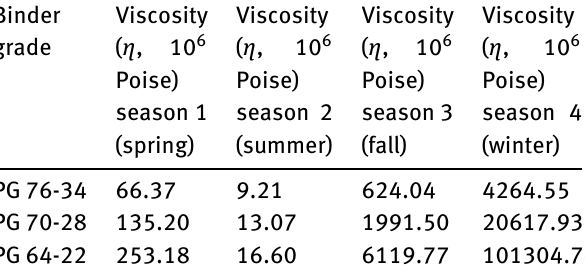
Table 6: Viscosity of binder PG76-34, PG70-28, and PG64-22. Binder